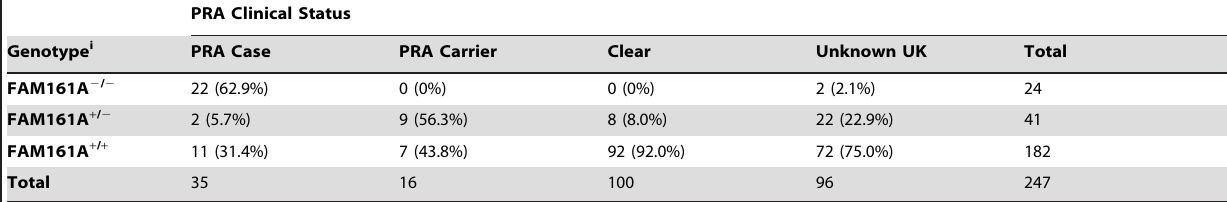
Table 1. PRA3 genotypes and PRA clinical status for 247